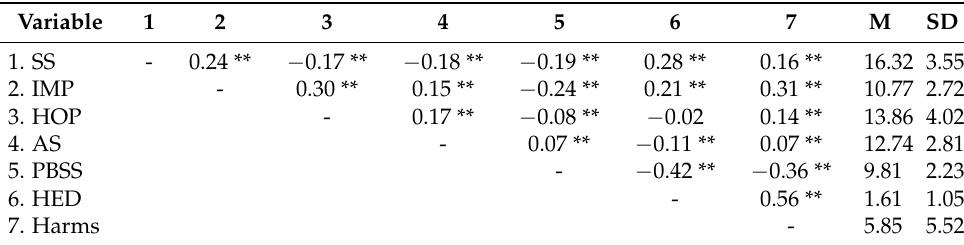
Table 3. Study 2: Means, standard deviations, and Pearson correlations between personality traits, protective behavioral strategies, heavy episodic drinking (HED), and alcohol-related harms.